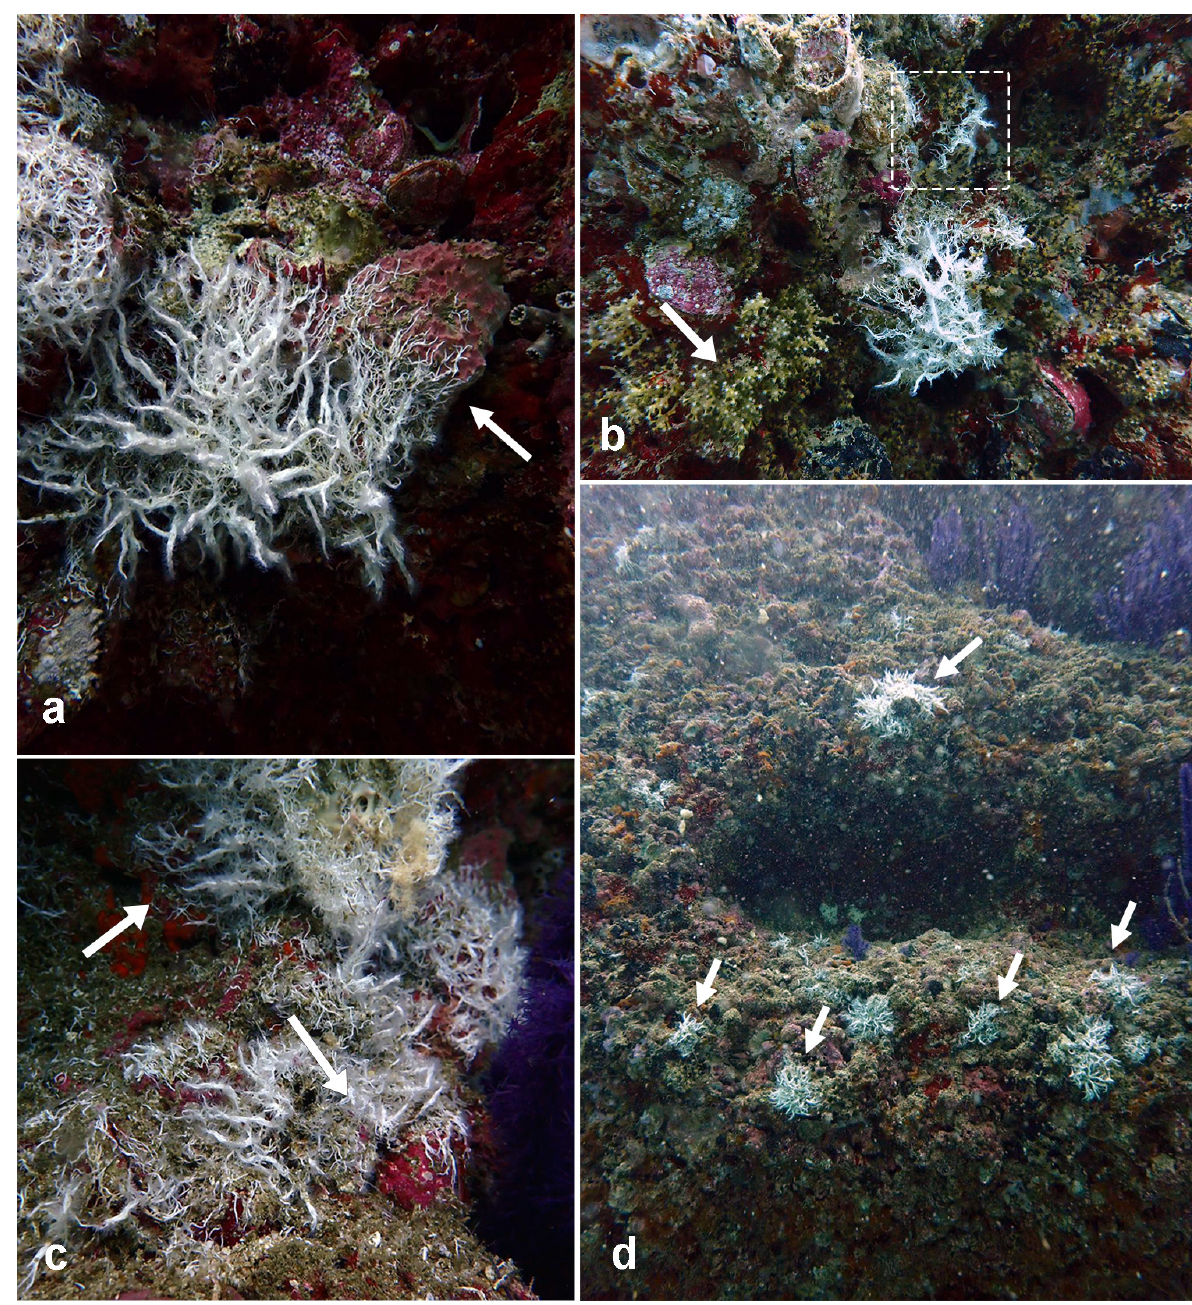
Figure 3. Rocky walls in the seaward side of the Daymaniyat Islands, reaching about 30 m depth, covered with Filograna/Salmacina aggregations ( a ) Aggregations starting with tubes overgrowing surfaces, then joining up, and building thicker branches. White arrow: overgrowth on a sponge. ( b ) Aggregations on overhangs, in between gorgonians, such as Bebryce stellata (white arrow), and Astrogorgia sp. (square outline), slowly getting smothered by the overgrowing worms. ( c ) Worms growing over rocks, crustose coralline algae, and sponges. ( d ) View of the wall in upward direction, with worm pseudo-colonies up to 20 cm in diameter (photos J. Al Asfoor).